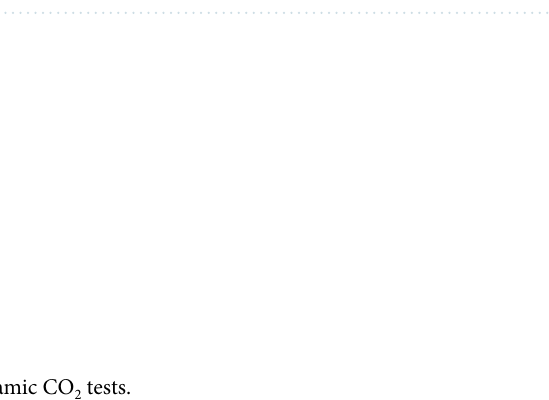
Table 1. Reservoir oil composition and SARA tests. Saturate = 50.2%, Aromatic = 26.10%, Resin = 4.70%, Asphaltene = 22%.